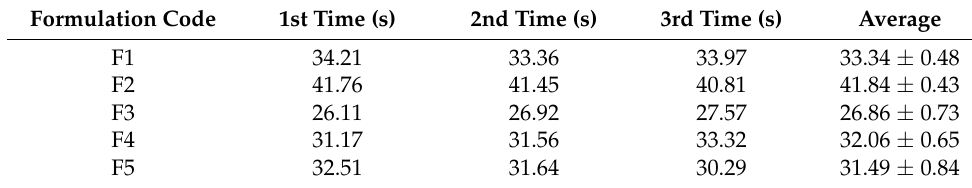
Table 4. Spreadability values of EU-loaded nanoemulgels (mean ± SD).